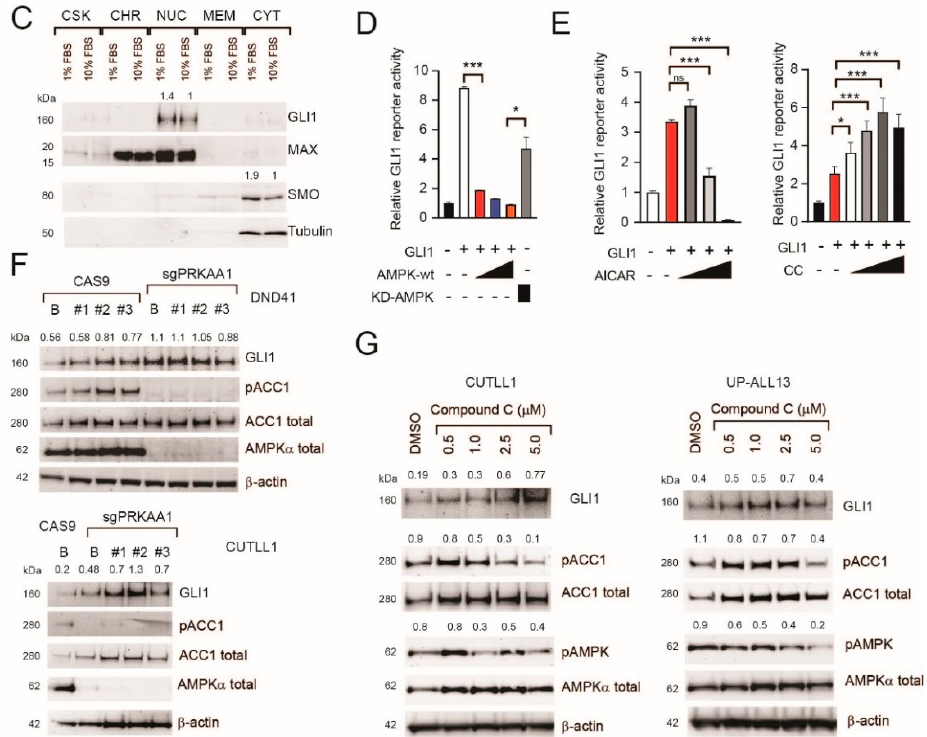
Figure 2. Analysis of signaling pathways modulated following acute nutrient deprivation. ( A ) Cellular fractionation of Jurkat T-ALL cells cultured in nutrient-replete conditions (10% FBS) or nutrient-depleted conditions (1% FBS) for 24 h and evaluated for the activation of specific signaling pathways (PI3K– AKT–mTOR, MAPK–RSK, AMPK, and CK2). Fractions: CSK = cytoskeletal; CHR = chromatin bound; NUC = nuclear; MEM = membrane; CYT = cytoplasmic. The ratio between phosphorylated and total protein is shown for each signaling molecule. ( B ) Cellular fractions of Jurkat T-ALL cells cultured in nutrient-replete conditions (10% FBS) or nutrient-depleted conditions (1% FBS) for 24 h were subjected to immunoblotting and hybridized with anti-phospho AMPK (top) or anti-phospho CK2-substrate (bottom) motif antibodies. ( C ) Cellular fractions of Jurkat T-ALL cells cultured in nutrient-replete conditions (10% FBS) or nutrient-depleted conditions (1% FBS) for 24 h were evaluated for the expression levels of HH pathway components (GLI1 and SMO). Max and tubulin were used as loading controls for nuclear and cytoplasmic fractions, respectively. Normalized GLI1 and SMO protein expression (relative to its loading control) is shown. ( D ) Dual luciferase reporter assay of HEK-293T cells transfected with GLI reporter and GLI1 or empty vector. The effects of increasing amounts of transfected AMPK on GLI reporter were evaluated. Wt = wild type; KD = kinase dead. Results of one of two experiments (with similar results) performed in triplicate are shown. Results are shown as the mean ± SD. * p < 0.05, *** p < 0.001. ( E ) HEK-293T cells transfected with GLI reporter and GLI1 (or empty vector) were treated with increasing amounts of AICAR (AMPK agonist; 0.5–2 mM; left panel) or Compound C (CC; 1–10 µ M; right panel). Relative luciferase activity is represented as fold change relative to empty vector. Results of one of two experiments (with similar results) performed in triplicate are shown. Results are shown as the mean ± SD. Ns = not significant, * p < 0.05, *** p < 0.001. ( F ) Immunoblot evaluating the expression levels of GLI1, phospho ACC1 (S79), total-ACC1, and AMPK α subunit in AMPK α knockout (sgPRKAA1) or control (CAS9) DND41 (top) or CUTLL1 (bottom) cells in the bulk population ( B ) or clones (#). β -actin was used as a loading control. Normalized GLI1 protein expression (relative to its loading control) is shown. ( G ) Immunoblot evaluating the expression levels of GLI1, phospho ACC1 (S79), total-ACC1, phospho AMPK (T172), and total AMPK α in CUTLL1 (left) or UP-ALL13 (right) cells treated with increasing concentrations of Compound C or vehicle. β -actin was used as a loading control. Normalized GLI1 protein expression (relative to its β -actin loading control) is shown. The ratio between phosphorylated and total protein is shown for ACC1 and AMPK α